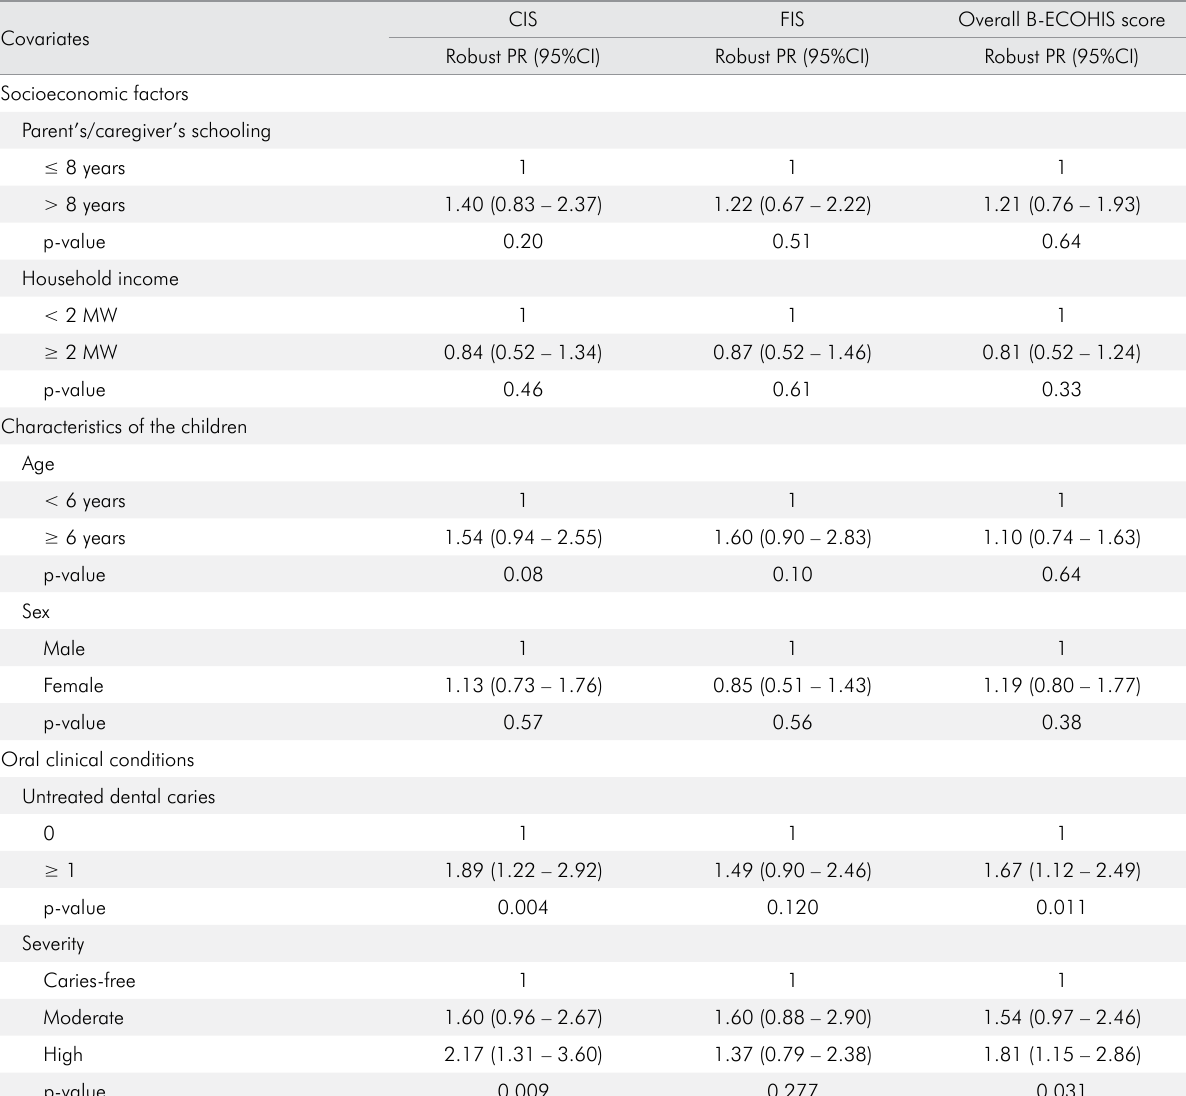
Table 4. Final Poisson regression model for covariates associated with the CIS, FIS, and overall B-ECOHIS score.